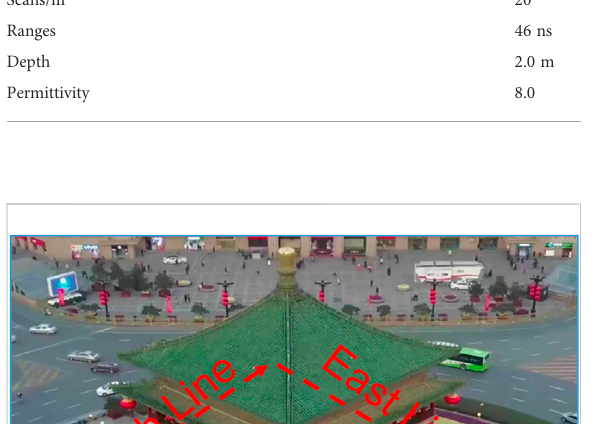
Figure 10C are: W1~W3; and the anomalous re fl ections in Figure 10D are: N1~N3. These signi fi cant anomalous re fl ections canbedividedintotwocategories. The fi rstcategoryasE1, E2, E3,E4, E5, S1, S2, S3, S4, S5, W1, W2, and W3are hyperbolic winding waves.